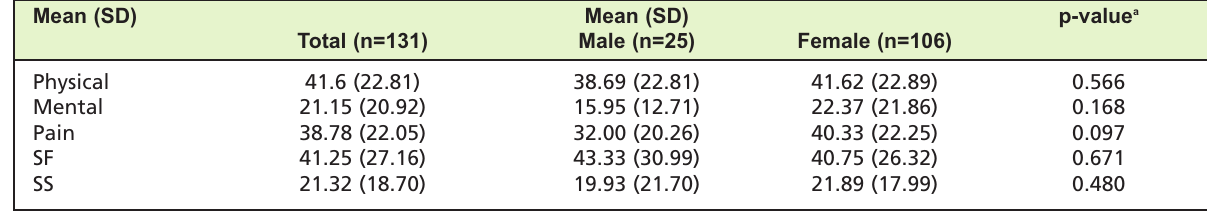
HRQOL according to gender by using OAKHQOL questionnaire (n = 131) Table V: